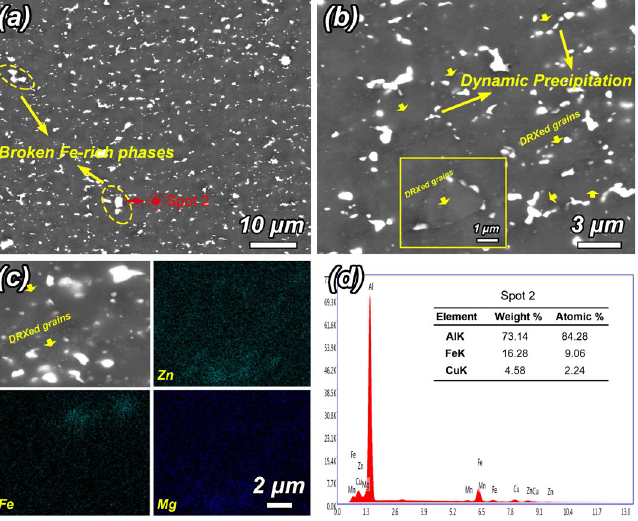
Figure 12. Backscattered SEM images of the inner wall region of extruded samples selected from different N.